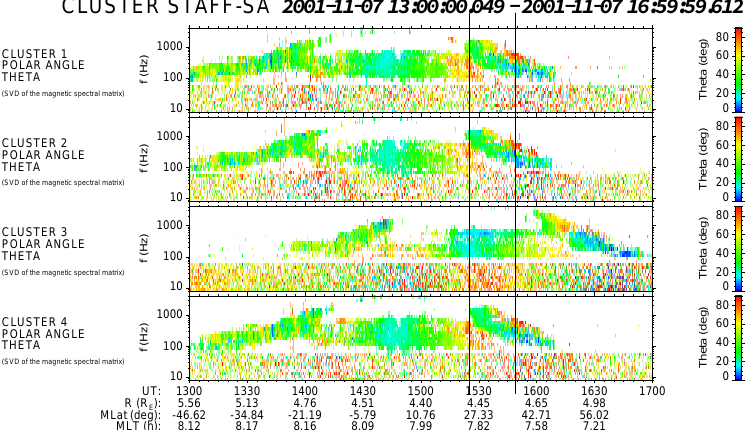
Fig. 7. Same as Fig. 2 but for 7 November